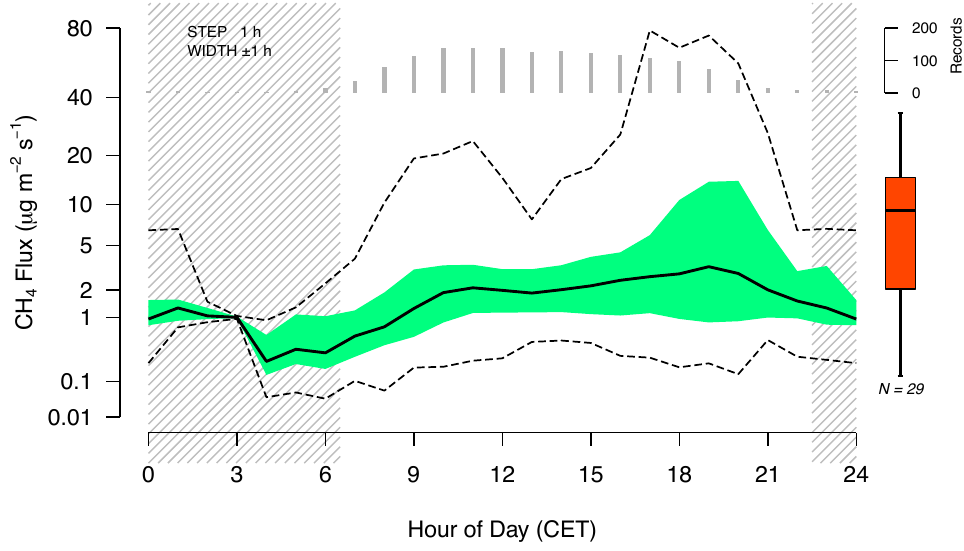
Fig. 7. CH 4 effluxes as a function of hour of day which reflects the hydropower generation. The typical diurnal pattern sees highest lake level in the morning and lowest in the evening (before 22:00CET), which most likely causes the diurnal variability observed in CH 4 effluxes. Shaded areas denote hours of day with less than 10 observations. Chamber flux measurements are added to the right as in Fig. 5